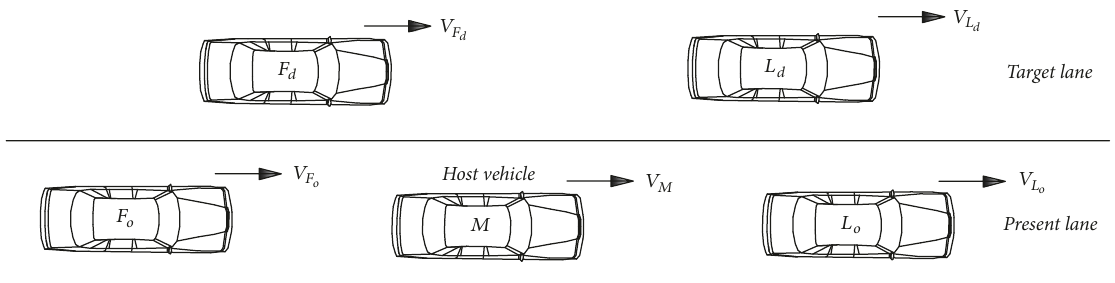
Figure 1: Position of the host vehicle relative to the surrounding